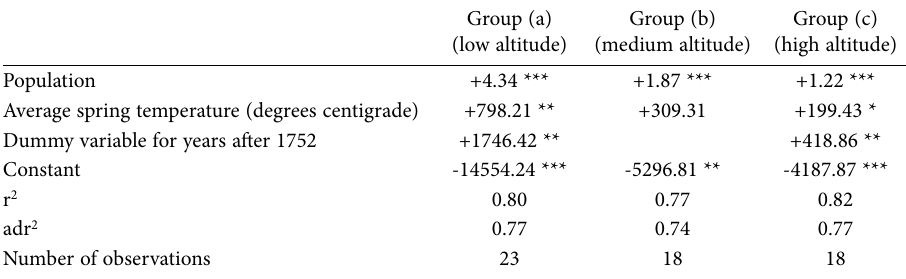
Table 2. Estimation results for three different groups of mountain